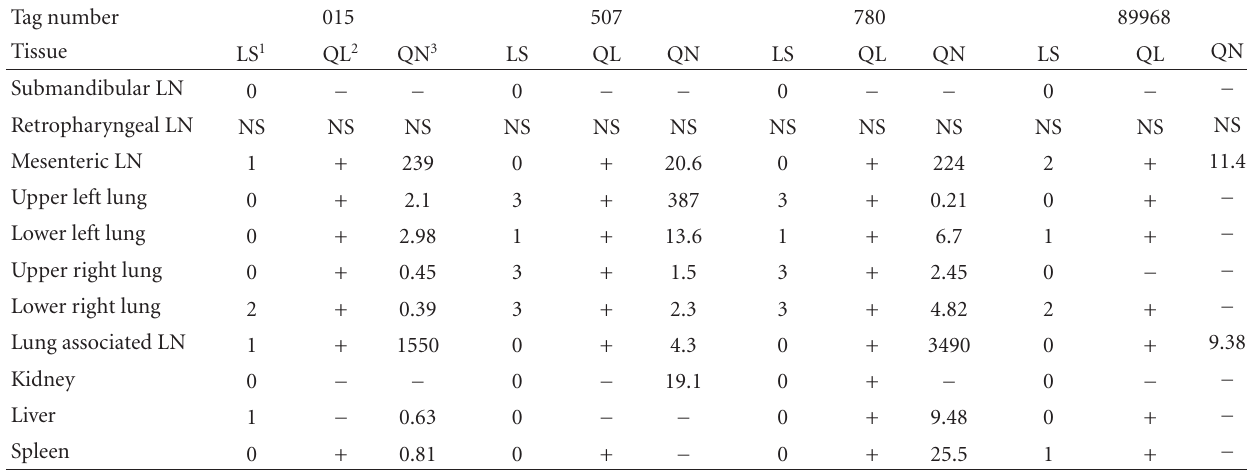
Table 4: Isolation of M. bovis from a range of tissues taken from 4 ferrets infected with 1 . 1 × 10 3 CFU and examined postmortem at 20 weeks post infection.